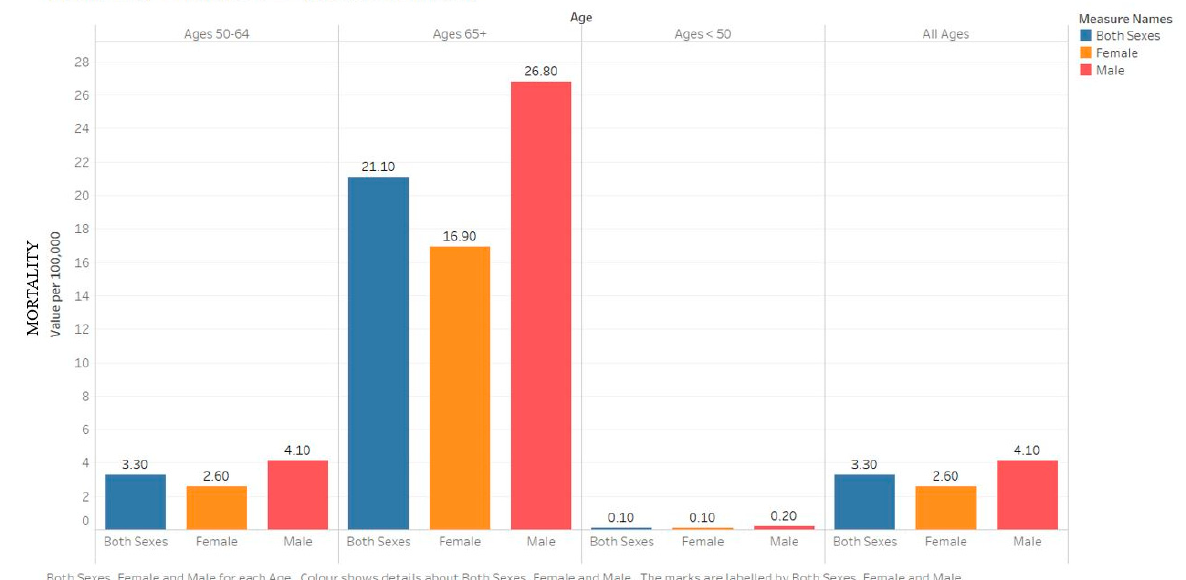
Figure 5. Bar chart showing the 5 year age-adjusted mortality rates from 2013–2017 by age for the United States. Created with Tableau 2019.2. Data source: SEER*Explorer [11].